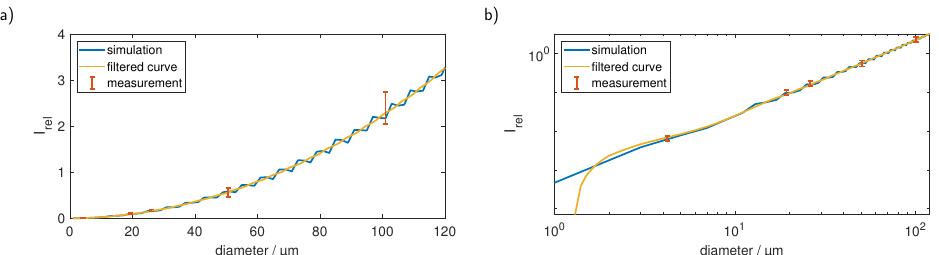
Figure 8. The simulated curve depicted together with the Savitzky–Golay smoothed one and the measurements in a ( a ) linear and a ( b ) double-logarithmic plot. Scaling the simulation to the mea- surement was done by dividing every point of the simulated curve through the simulated value at 50.7 µm and then multiplying it with the measured intensity for the sphere with a diameter of 50.7 µm.